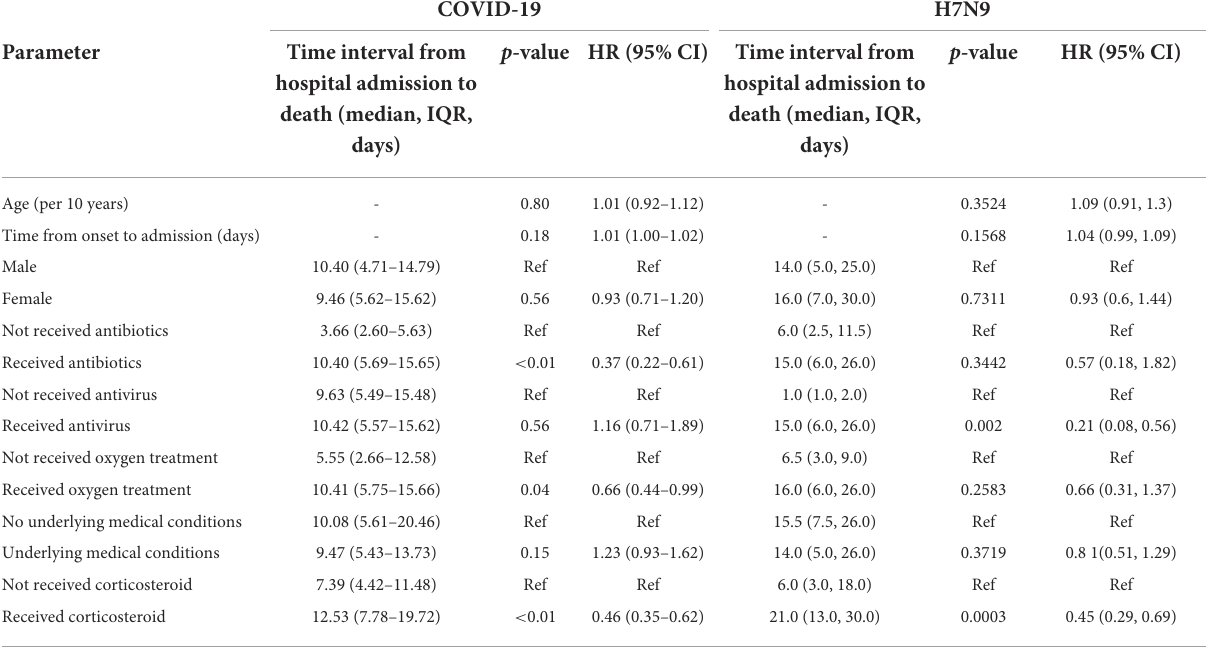
TABLE 3 Forest plot of factors associated with survival time interval based on hazard ratio (HR) from hospital admission to